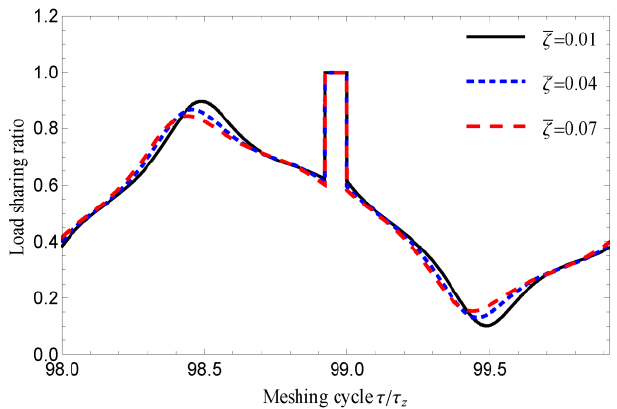
Figure 29. Load sharing ratio of a single pair of teeth under different 𝜁̅ .